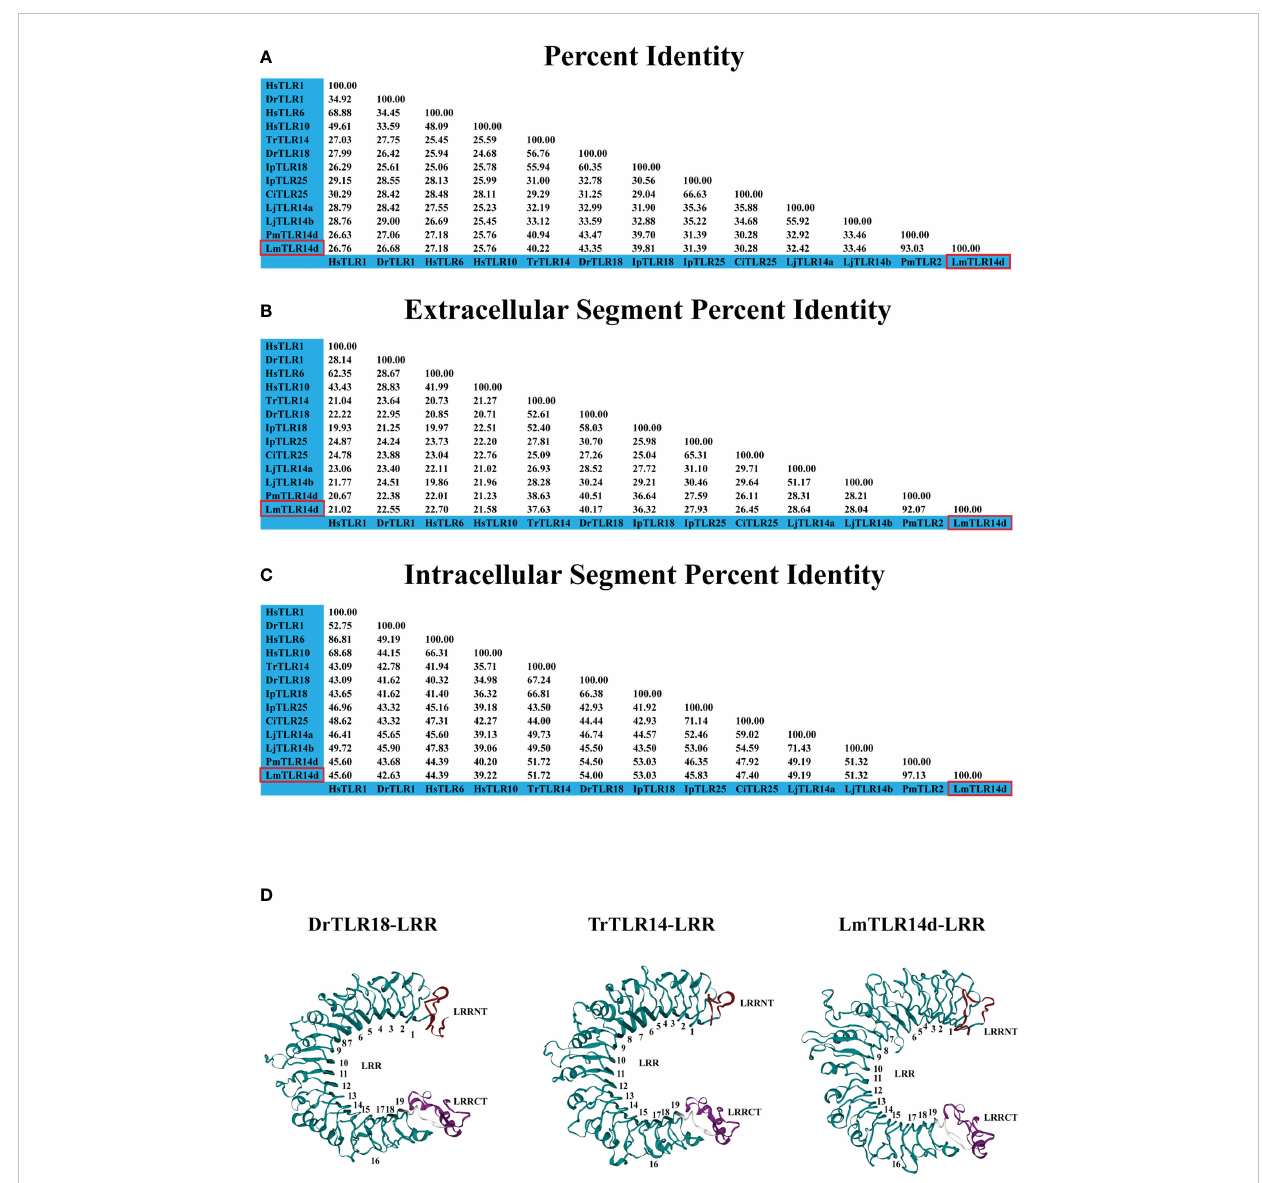
FIGURE 2 Deep analysis of homology and domain characteristics of LmTLR14d. Sequence full length percent identity (A) , extracellular segment percent identity (B) intracellular segment percent identity (C) analysis of L. morii TLR14d. (D) The 3D structure of the LmTLR14d, DrTLR18 ( Danio rerio TLR18) and